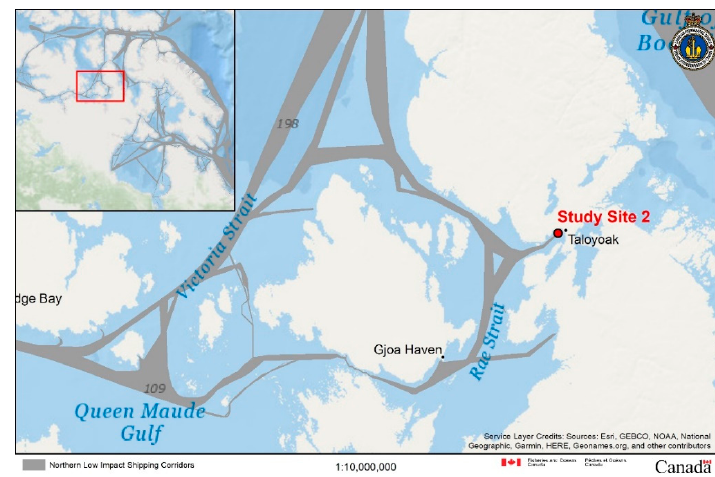
Figure 4. Location of Study Site 2, near Taloyoak, Nunavut. ISPRS Int. J. Geo-Inf. 2020 , x, x FOR PEER REVIEW